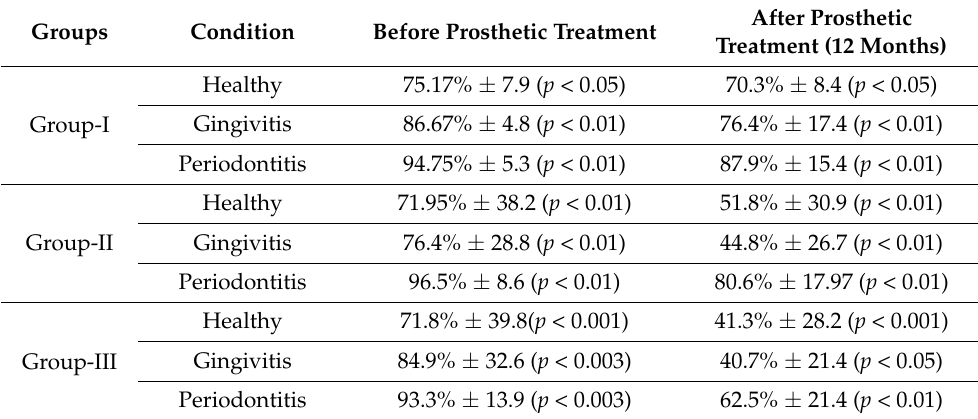
Table 3. MAPI data in all treatment groups before and after prosthetic